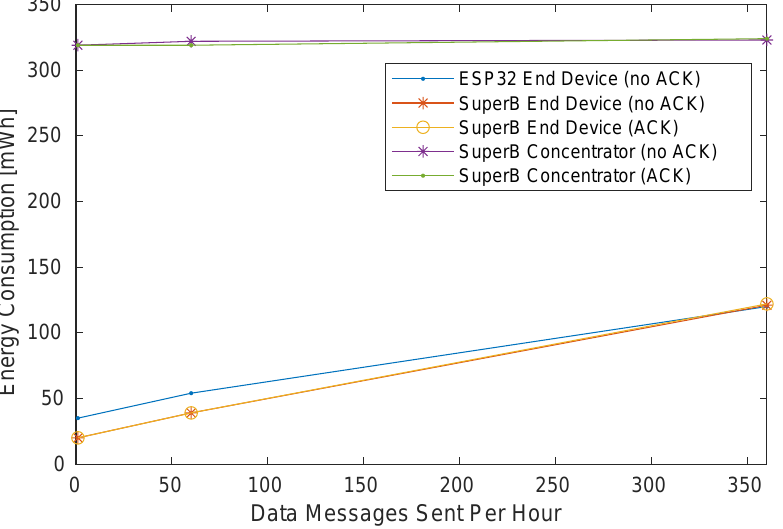
Figure 8. Energy Consumption based on Message Sending